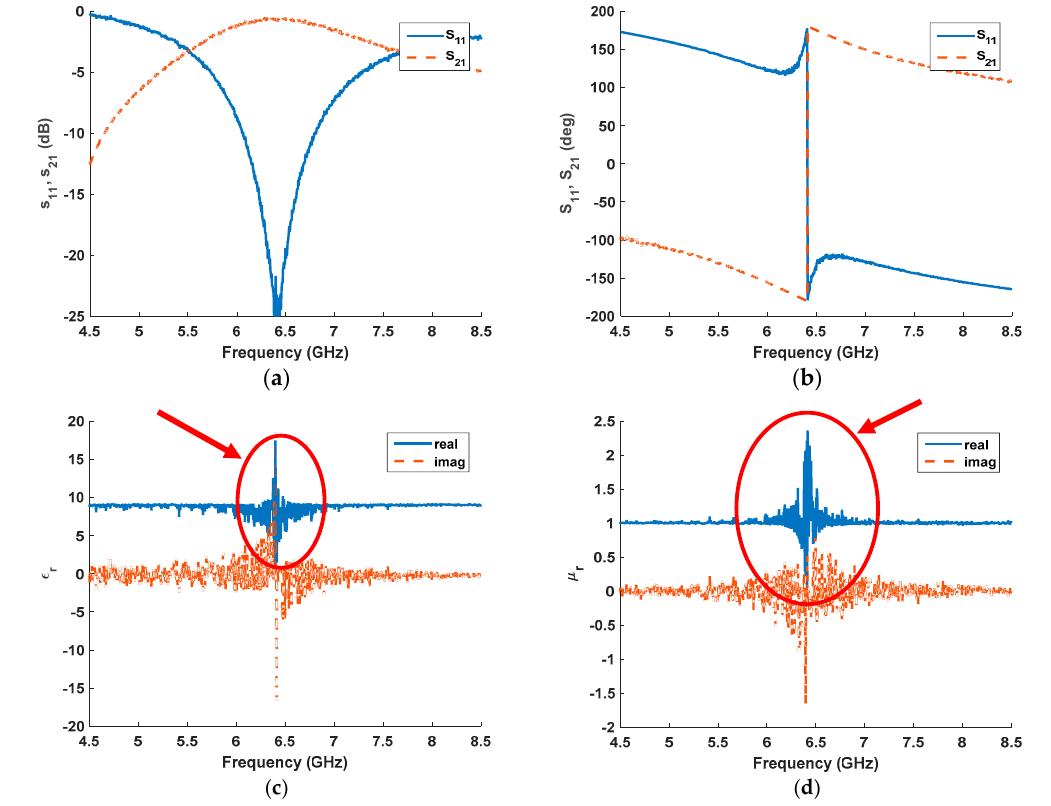
Figure 7. Scattering parameters for a sample of ε r = 9 − j0.2, µ r = 1 − j0 with d = 8 mm perturbed by Additive White Gaussian Noise (AWGN) with mean value m υ = 0 and standard deviation σ = 0.01 ( a , b ); estimated dielectric permittivity and magnetic permeability for n = 0 for the first frequency point and stepwise algorithm ( c , d ).